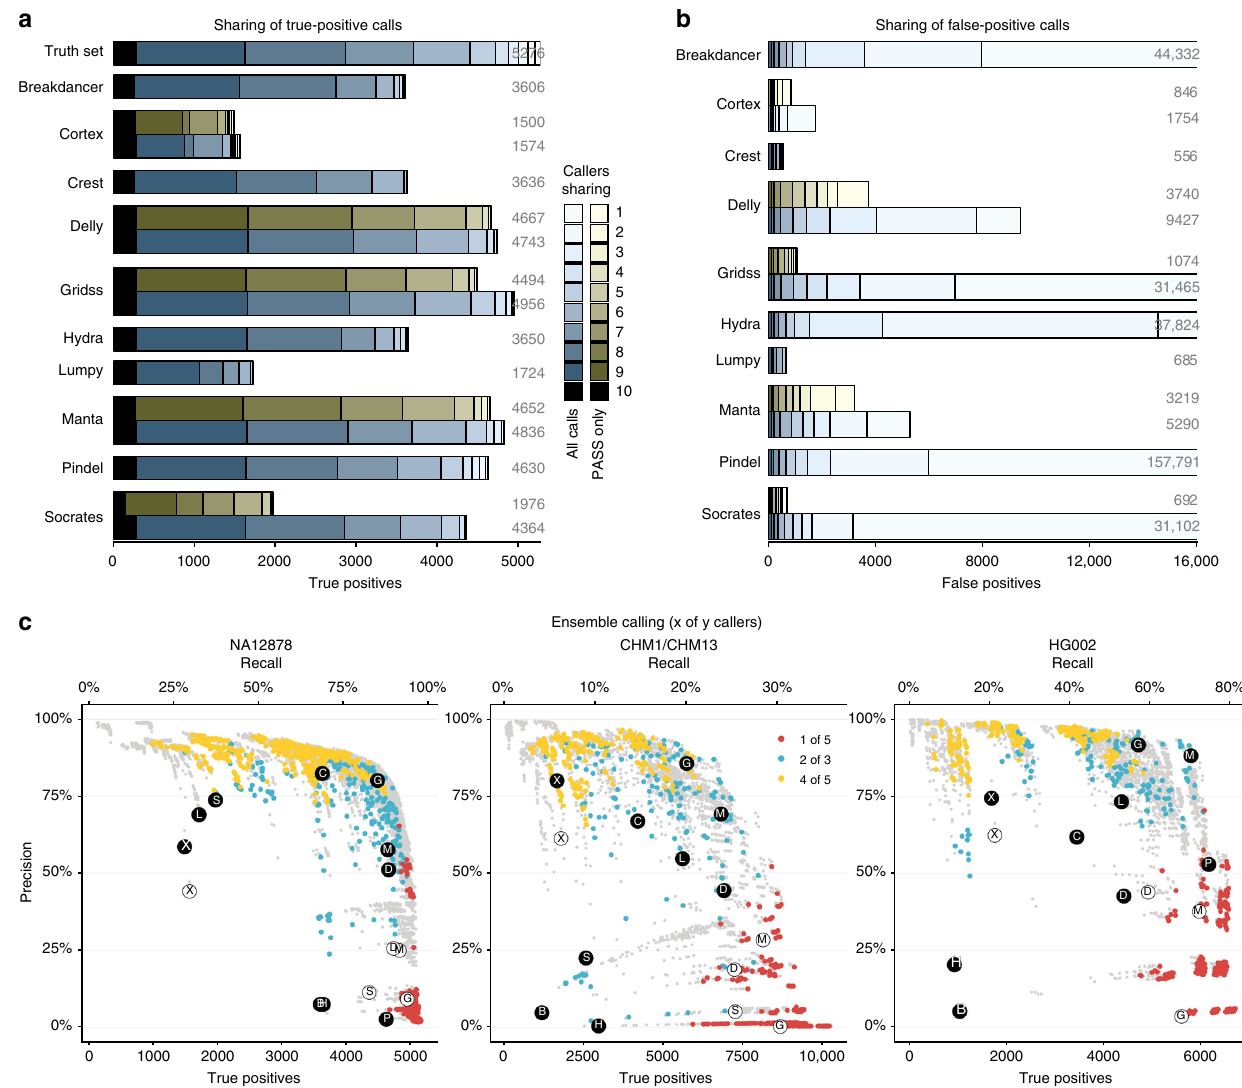
Fig. 3 Simple ensemble-based calling does not reliably improve performance. a Agreement between callers in NA12878. For each caller, true-positive calls are strati fi ed and shaded by the number of other callers in agreement. Both the full call set (blue) and the subset passing all caller-de fi ned fi lters (green) are reported for callers that report fi ltered variants. The top bar shows the strati fi cation of the truth set by number of callers detecting the variant. b Agreement between callers for false positives. c Precision vs. number of true positives/recall for all possible m -of- n ensembles (grey points) compared with individual callers (larger circles). 1 of 5, 2 of 3, and 4 of 5 ensembles are highlighted in